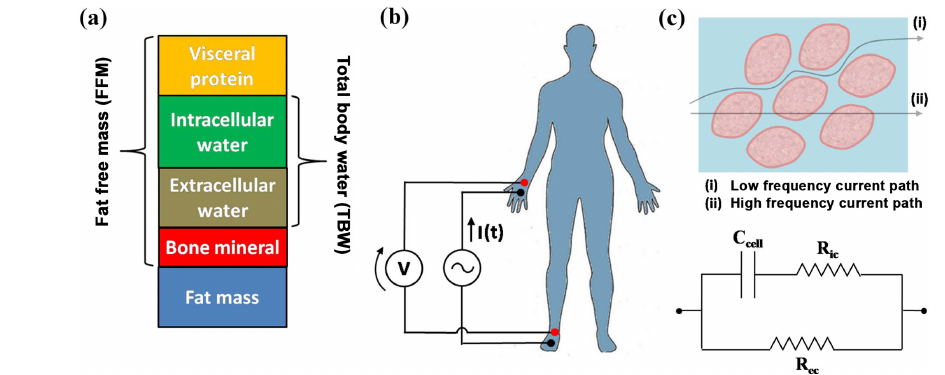
Figure 4. (a) The different compartments of the human body; (b) a typical four-electrode configuration for BIA measurements; (c) equivalent electrical circuit used to interpret measured data in